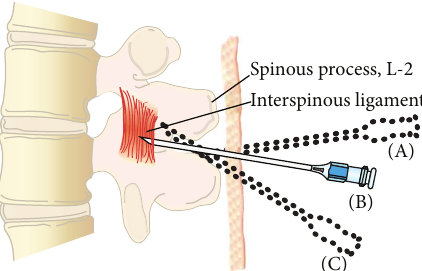
Figure 2: Midline approach to the subarachnoid space. The spinal needle is inserted with a slight cephalad angulation and should advance in the midline without contacting bone (B). If bone is contacted, it may be either the caudad (A) or the cephalad spinous process (C). The needle should be redirected slightly with cephalad and reinserted. If bone is encountered at a shallower depth, the needle is likely walking up the cephalad spinous process. If bone is encountered at a deeper depth, the needle is likely walking down the inferior spinous process. If bone is repeatedly contacted at the same depth, the needle is likely off the midline and walking along the